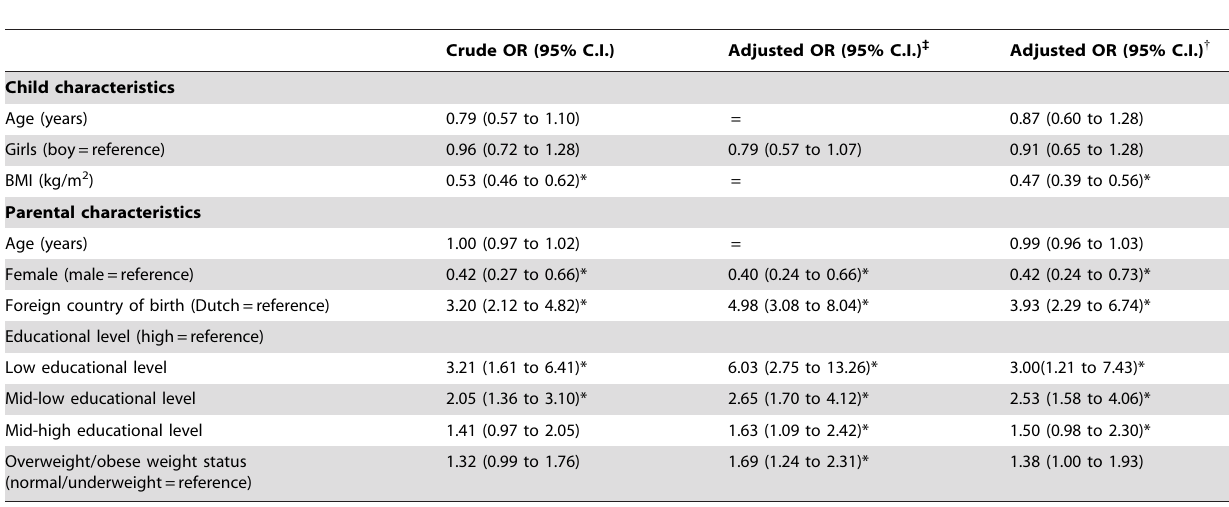
Table 2. Multivariable logistic regression analysis, presenting Odds Ratio’s (OR) for correlates of parental misperception about child’s weight status.